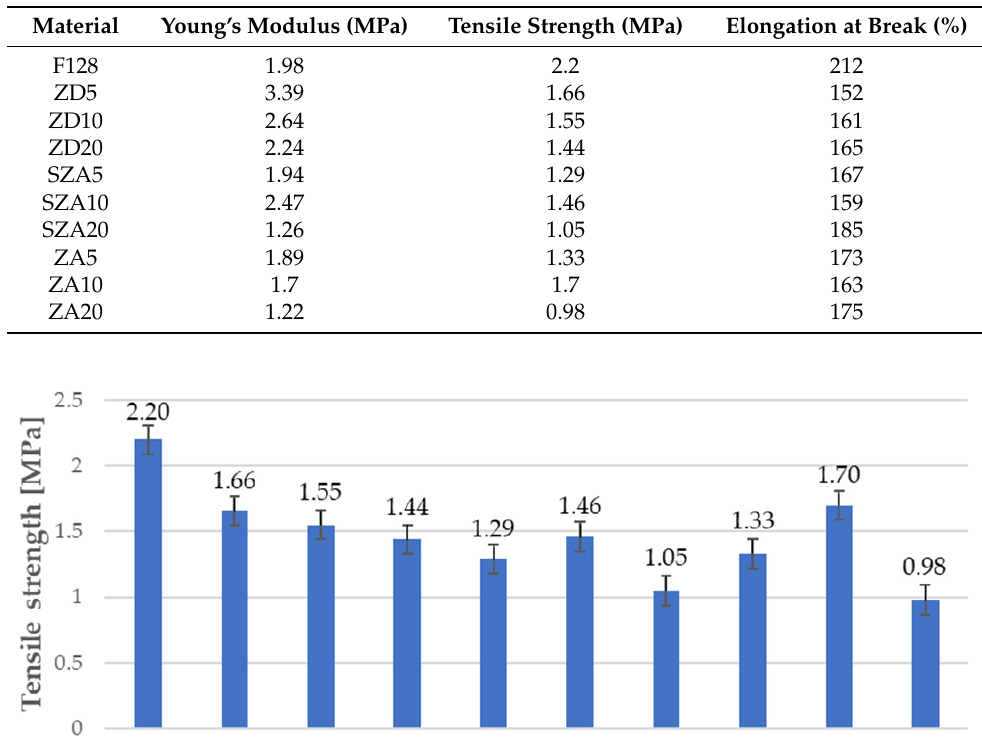
Table 5. Mechanical properties of the tested materials.